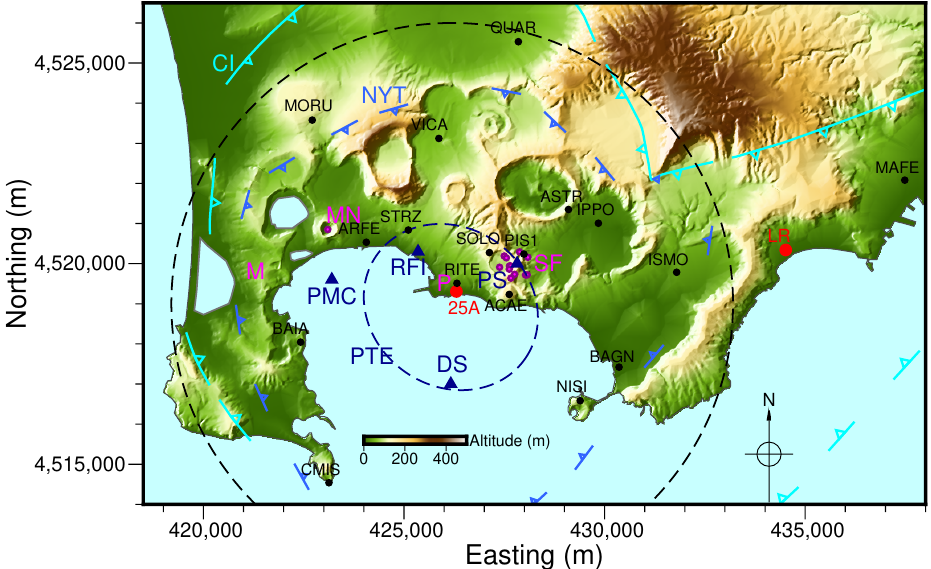
Figure 1. Map of the Campi Flegrei caldera, UTM WGS84 33N coordinates. Colors give topogra- phy [3]. Cyan and light blue discontinuous lines with triangles indicate the Campanian Ignimbrite (CI) and Neapolitan Yellow Tuff (NYT) caldera borders, respectively (adapted from [2]). Magenta labels and dots: M, Mofete area; MN, Monte Nuovo; P, Pozzuoli; SF, Solfatara fumarolic field. Red la- bels and circles: 25A, leveling benchmark in the area of maximum vertical displacement; LR, reference benchmark for levelings. Black labels and dots: continuous GPS stations [4] used to validate Sentinel 1A displacement time series; GPS and SAR displacements are referred to MAFE for validation. Blue labels and triangles: PS, injection point of magmatic fluids into the hydrothermal system [5]; RFI, area of repeated fluid injections during 1983–1984 [6]; PMC, area of the fluid transfer connection between Pozzuoli and Mofete/Monte Nuovo where the spatial 1983–1984 seismic pattern turns from E-W to NW-SE [6]; DS, center of the deep reservoir contributing to 2015–2022 deformation. Blue label and dashed ellipse: PTE, border of the around 3500 m deep sill-like reservoir [5]. The black dashed circle bounds the area where EOFs of SAR displacements are